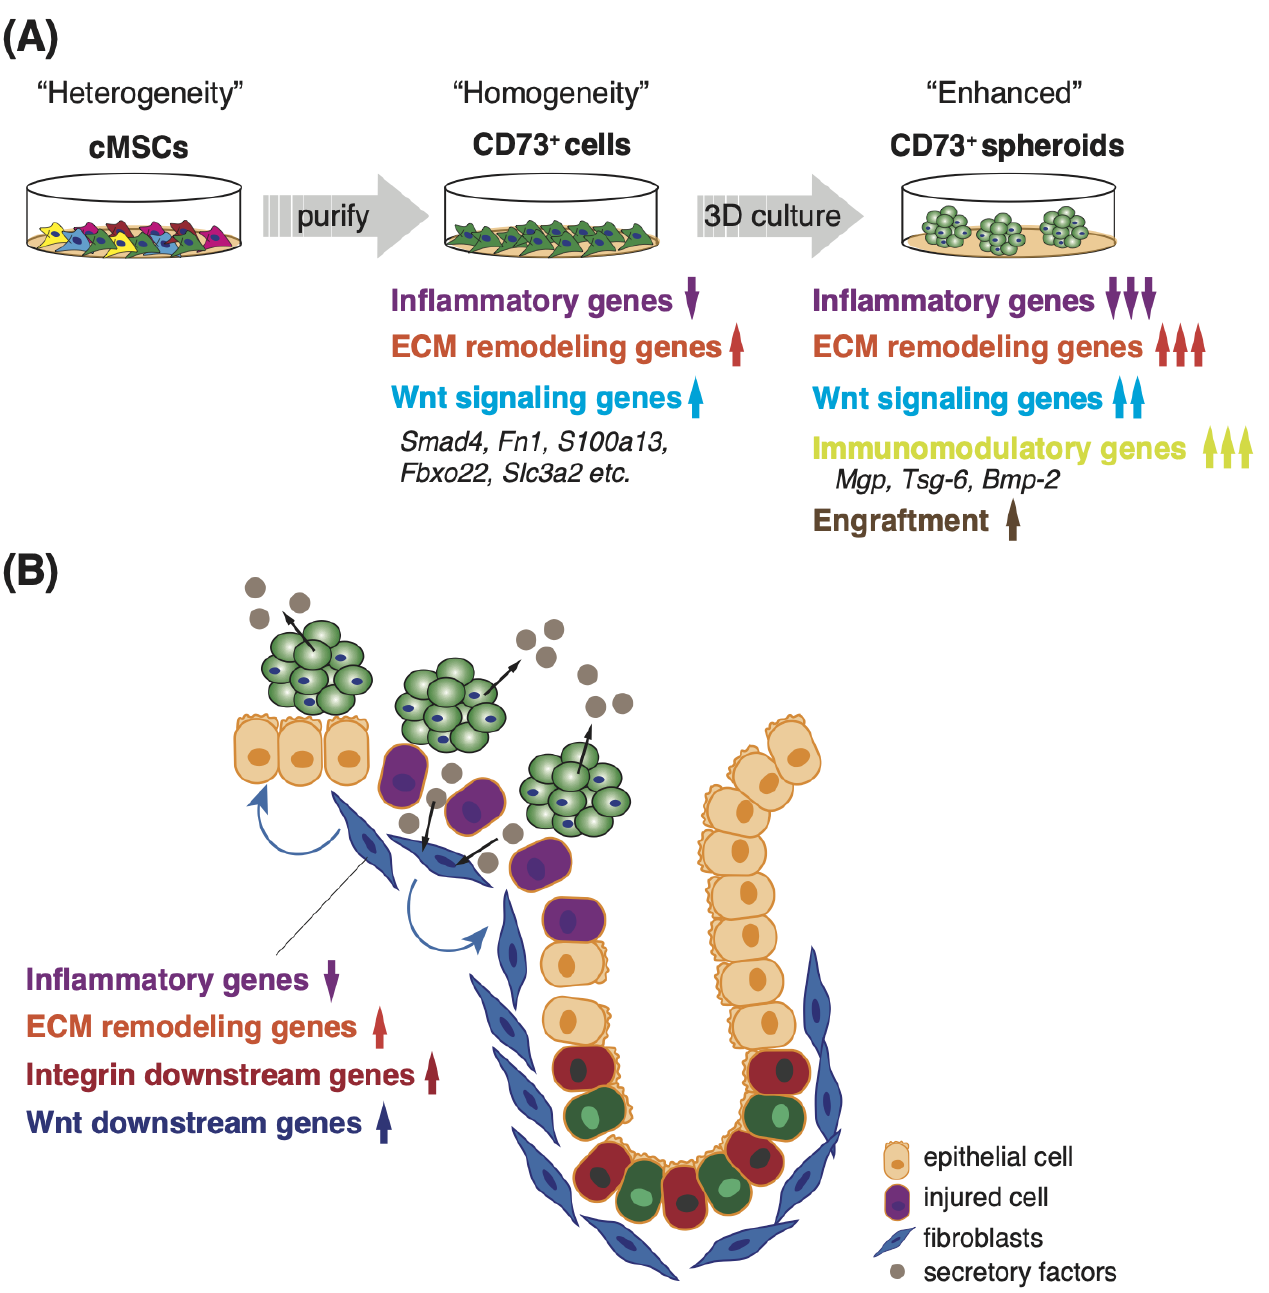
Figure 7. Proposed model for interaction between intestinal fibroblasts and transplanted CD73 + cell spheroids in DSS-induced colitis. ( A ) Compared with conventional heterogeneous MSCs, the homogeneous CD73 + cell population, purified by prospective isolation, exhibits characteristic gene expression, including the downregulation of inflammatory factors and the upregulation of ECM remodeling- and Wnt-signaling-related genes. Moreover, 3D culture-derived spheroids of CD73 + cells enhance these characteristics, and induce the upregulation of immunomodulatory factor expression, suggesting enhanced engraftment into colon tissues after DSS treatment. ( B ) Transplanted CD73 + cell spheroids attenuate colitis by modifying the phenotype of the tissue-resident fibroblasts, including downregulating the expression of inflammatory factors, and upregulating the expression of ECM remodeling- and Wnt signaling-related genes.